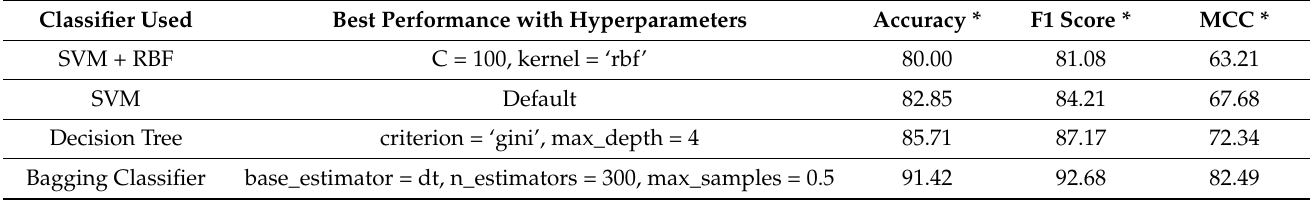
Table 4. Estimated performance over Dataset-1 under case-2.